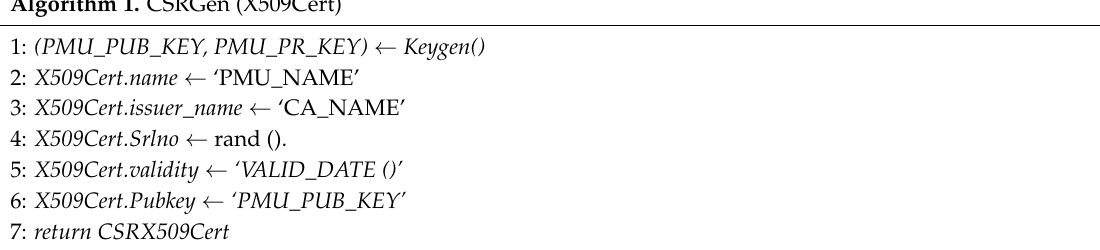
Algorithm 1. CSRGen (X509Cert)